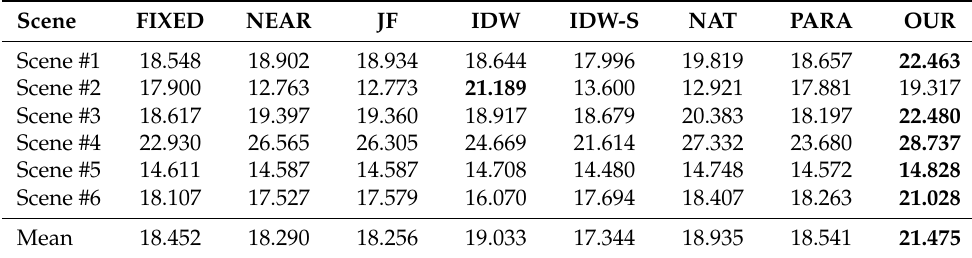
Table A2. PSNR scores of the presented approaches compared with our own approach. Higher score means higher similarity. The best results are highlighted in bold.